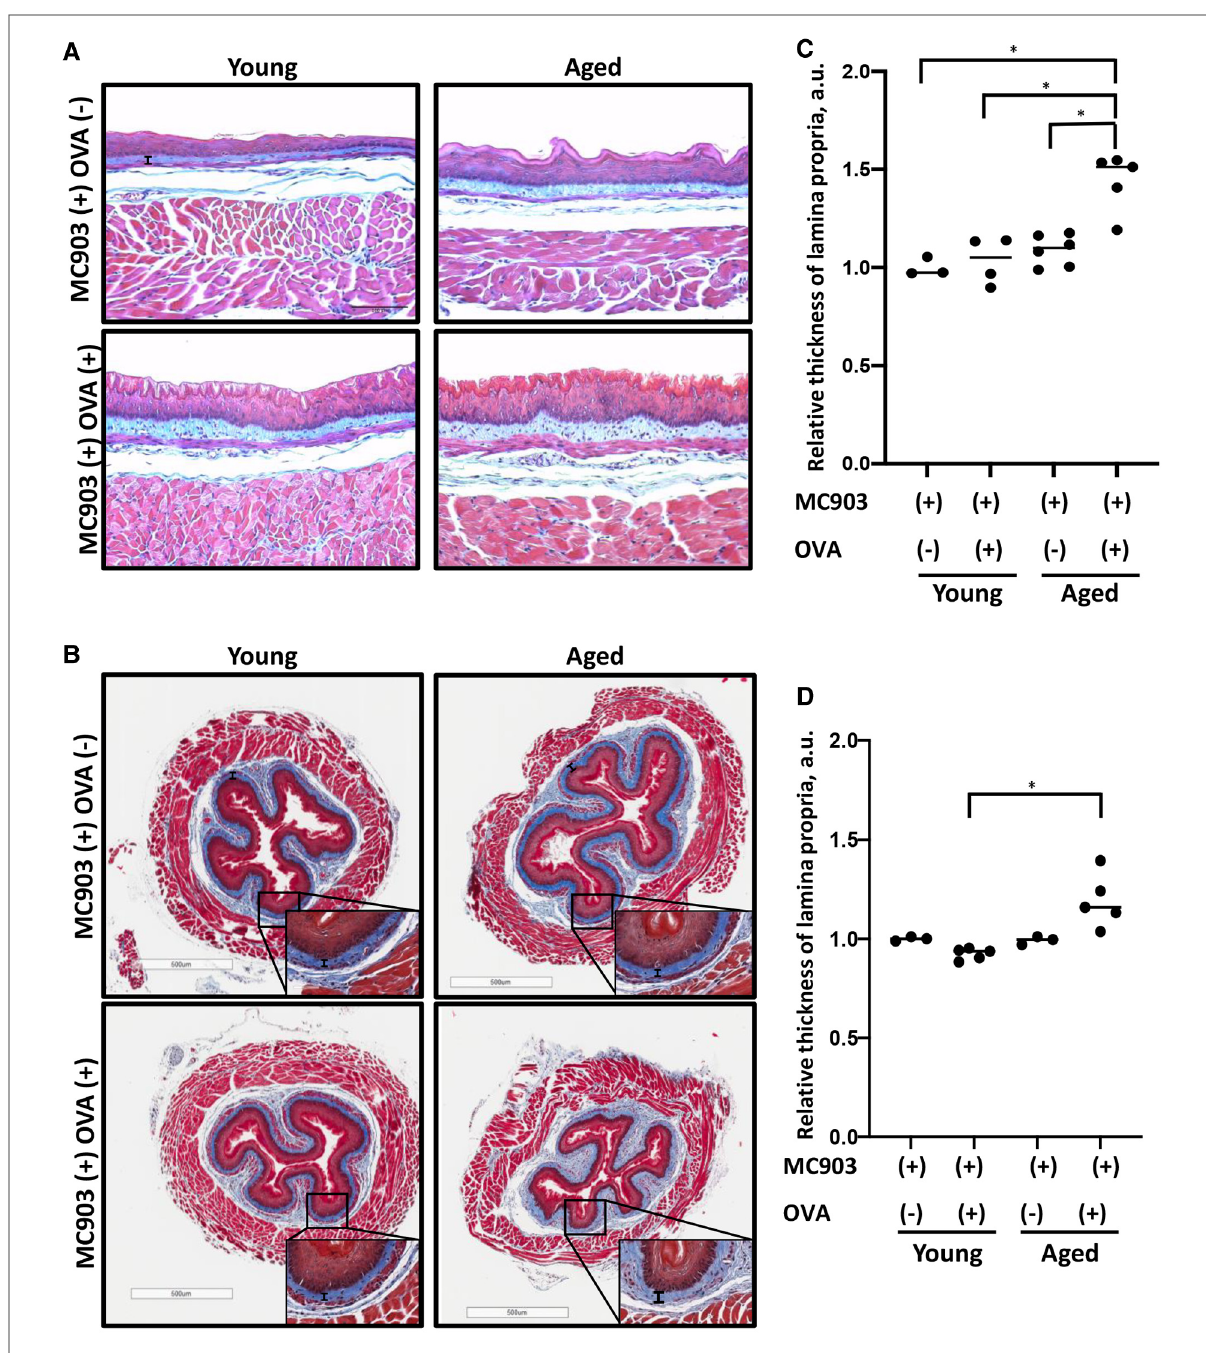
FIGURE 2 Lamina propria fi brosis is increased in aged mice with MC903/ovalbumin (OVA)-induced EoE. Esophageal tissue sections from young and aged mice treated with MC903±OVA were subjected to trichrome staining to assess fi brosis. ( A,B ) Representative sections of esophagi cut in the sagittal (in A ) or traverse plane (in B ). Scale bar, 100 μ m (in A ), 500 μ m (in B ). Thickness of lamina propria is delineated by vertical black bar. Insets (in B ) were imaged at 400X magni fi cation. ( C,D ) Lamina propria thickness relative to that of MC903(+) OVA( − )-treated young animals was determined for sections of esophagi cut in the sagittal (in C ) or traverse (in D ) plane. 11-20 individual measurements were taken for each animal, where each dot represents mean for one animal and bar represents median. Two-way ANOVA testing with Tukey ’ s correction was used to determine signi fi cance. * p ≤ 0.01. Data are from two independent experiments including four groups: young MC903(+) OVA( − ) ( n =3); young MC903(+) OVA(+) ( n =4 and 5, respectively); aged MC903(+) OVA( − ) ( n =6 and 3, respectively); and aged MC903(+) OVA(+) ( n